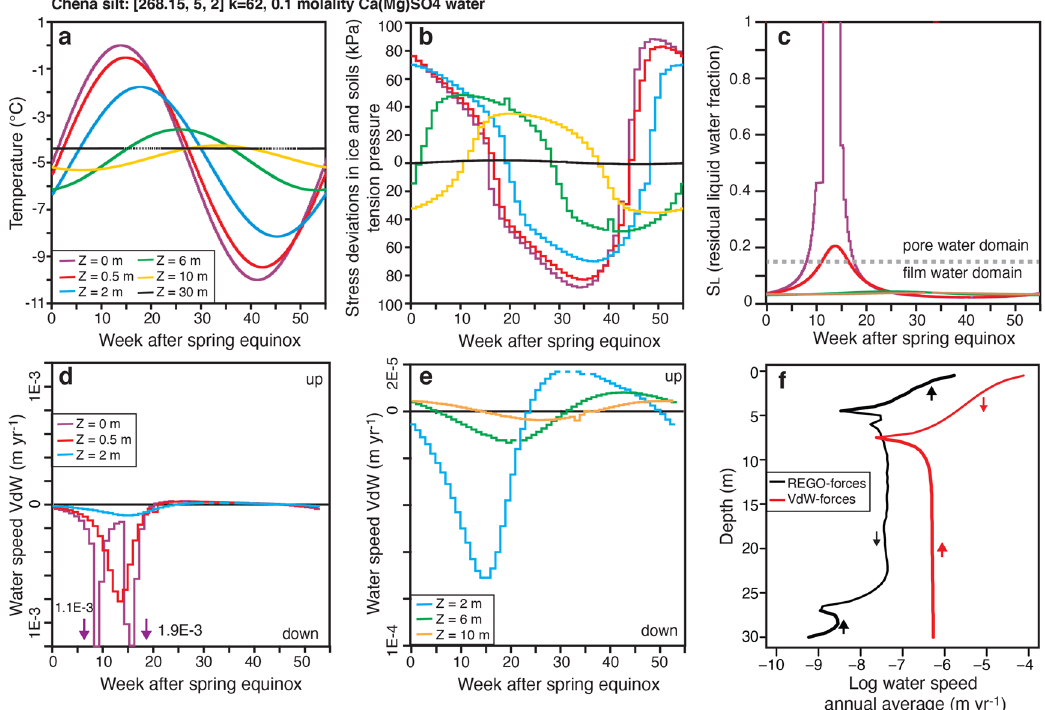
Fig. 5 Typical weekly variations in ground temperature, stress, and unfrozen water content, and the VdW-induced water speeds within Chena silt permafrost with Ca(Mg)SO 4 water chemistry. Weekly variation measured from the spring equinox in a ground temperature, b stress deviations in permafrost, c unfrozen water content, d , e maximum water speeds induced by VdW forces in 30 m Chena silt permafrost with Ca(Mg)SO 4 water chemistry, and f pro fi les of annual averages water speed from REGO forces and VdW forces up to 30 m depth. Numerical simulation was performed for mean annual ground surface temperature of – 5 °C, amplitude of 5 °C, and thermal diffusivity of 62 m 2 yr − 1 . Table 3 lists values used in the WATEREGO